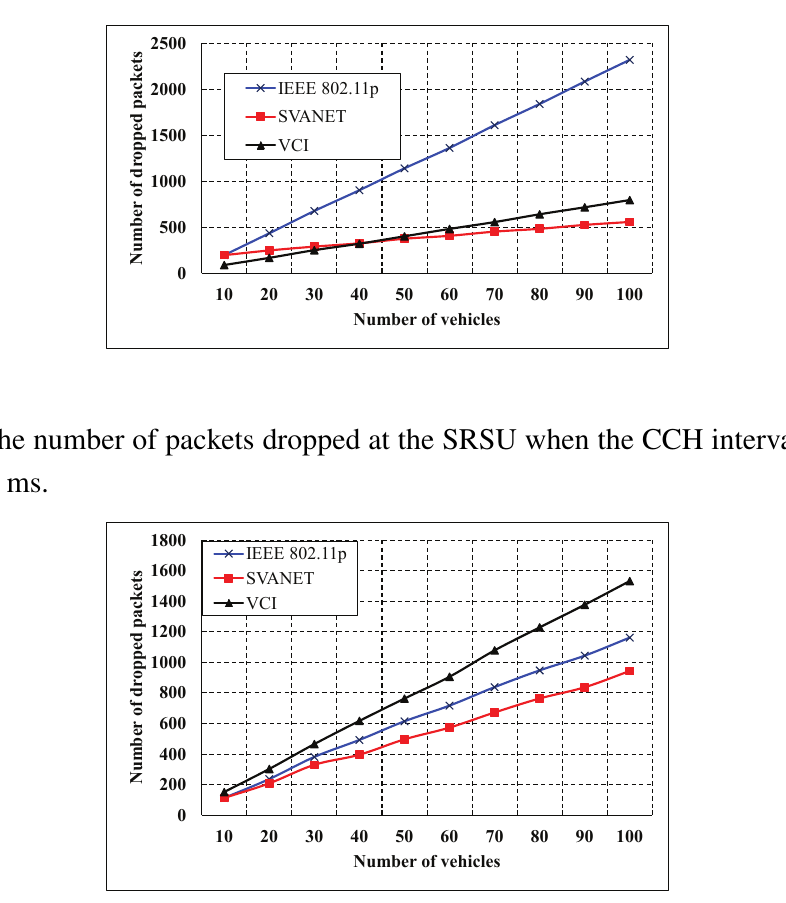
Figure 13. The number of packets dropped at the SRSU, when the CCH interval is between 50 ms and 100 ms.